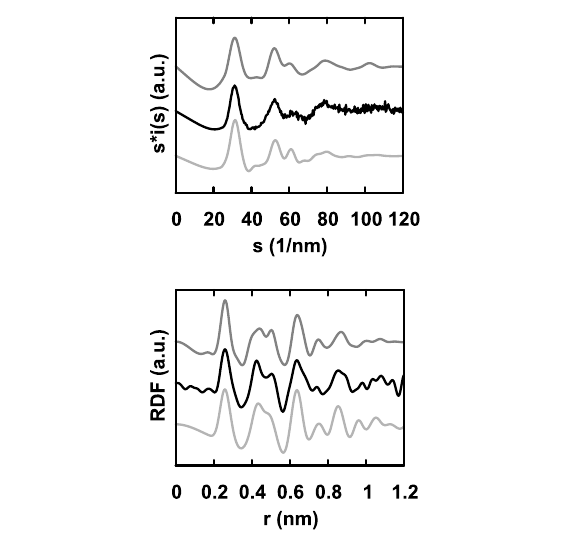
Figure 2: WAXS diagram (top) and the related RDF (bottom). Black: Fe NPs taken at room temperature; dark grey (top): Mn beta model; medium grey (bottom): van de Waal